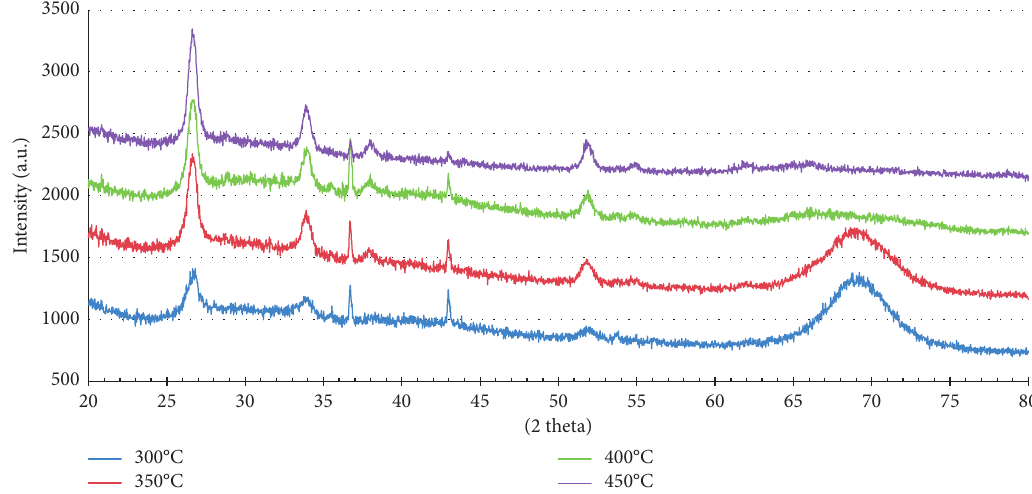
Figure 2: The XRD patterns of SnO 2 powder calcined at different